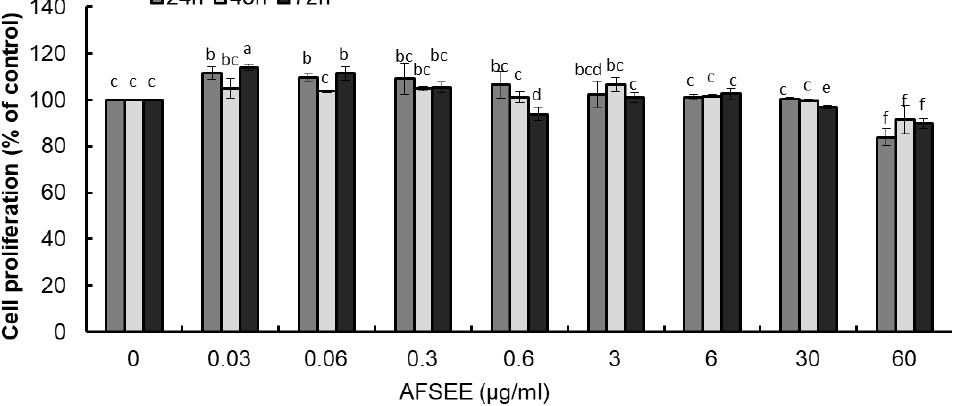
Figure 1. E ff ect of argan fruit shell ethanol extract (AFSEE) on B16F10 cell proliferation, determined using the 3-(4,5-dimethylthiazolyl-2)-2,5-diphenyltetrazolium bromide (MTT) assay. B16F10 cells were treated with AFSEE (0–60 µ g / mL) for 24 h, 48 h, or 72 h. Each bar represents the percentage of viable cells relative to the control, expressed as mean ± standard deviation (SD) of four independent experiments, each one performed in triplicate. Data was subjected to ANOVA ( n = 3). All comparisons were made between treatments. Di ff erent letters indicate treatment di ff erences at the p ≤ 0.05